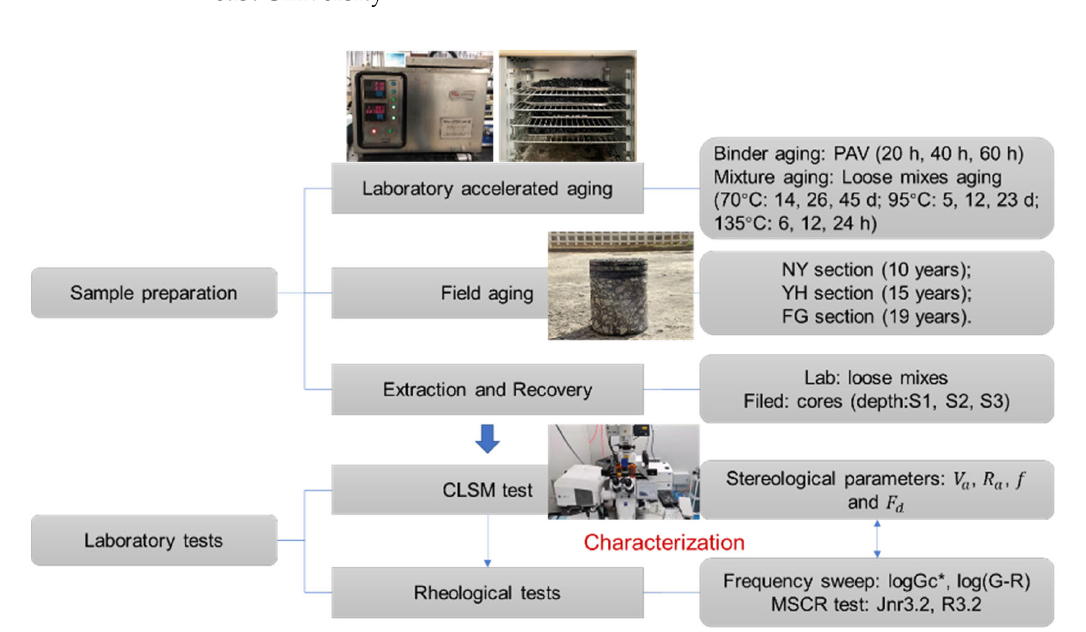
Figure 1. Flowchart of sample preparation and laboratory tests.